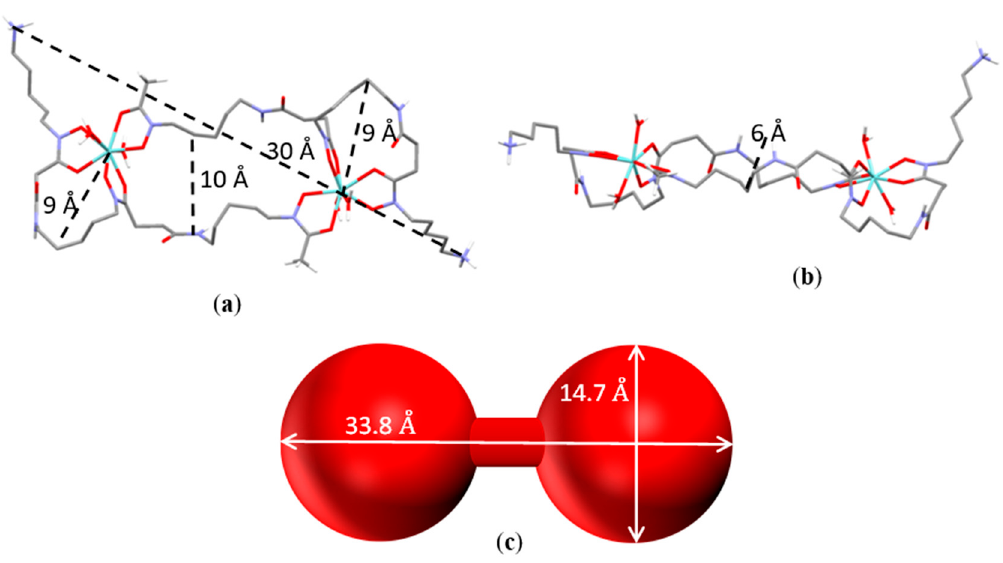
Figure 6. Calculated lowest energy conformer of [Zr 2 H 2 (DFO) 2 ] 4 + : Top ( a ) and lateral ( b ) views. ( c ) The barbell model of the main complex obtained from small-angle X-ray scattering (SAXS) measurements in solution ([Zr 4 + ] = [H 3 DFO] = 0.08–0.008 M).